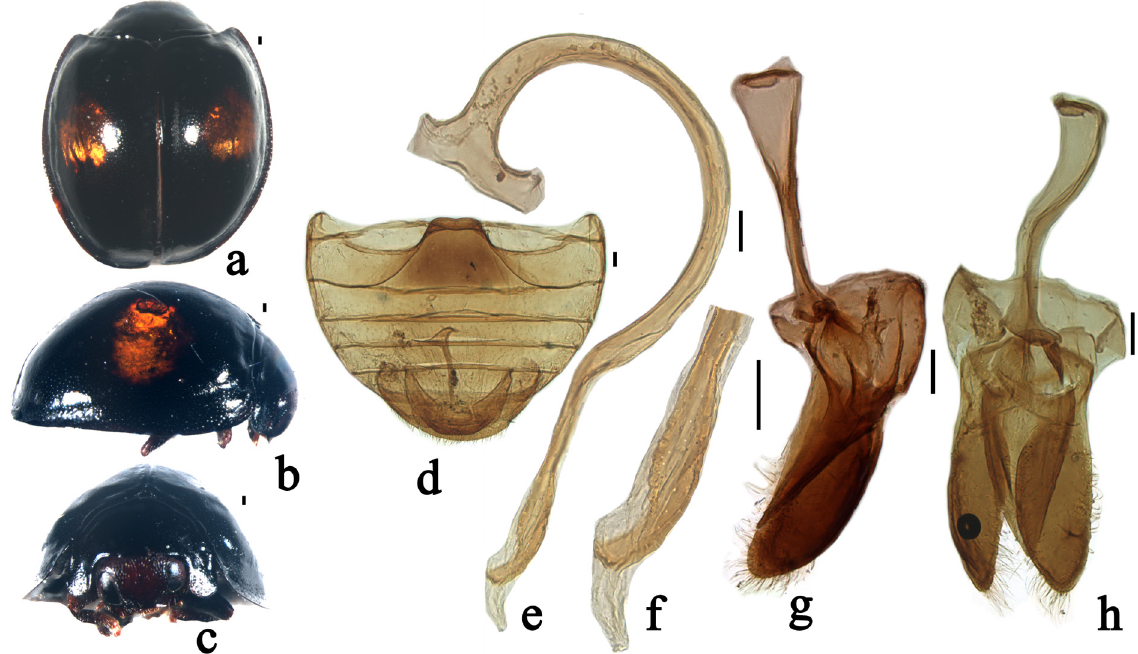
Fig. 14. Chilocorus strenotubus Li & Wang sp. nov., holotype a . Dorsal view. b . Lateral view. c . Frontal view. d . Abdomen. e . Penis. f . Apex of penis. g . Tegmen, lateral view. h . Tegmen, ventral view. Scale bars: 0.1 mm. (SCAU